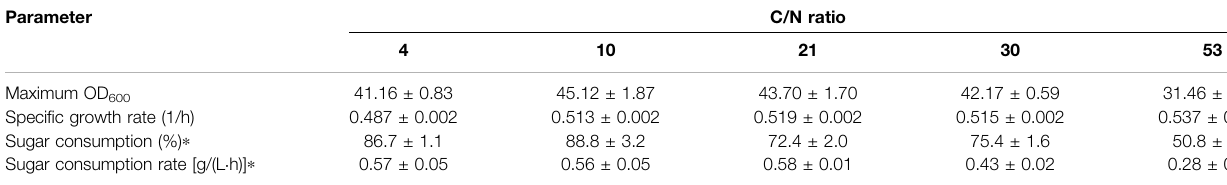
TABLE 2 | Kinetic parameters of Paracoccus sp. KKU01 growth on sugarcane juice-based medium at C/N ratios of 4 to 53. Parameter